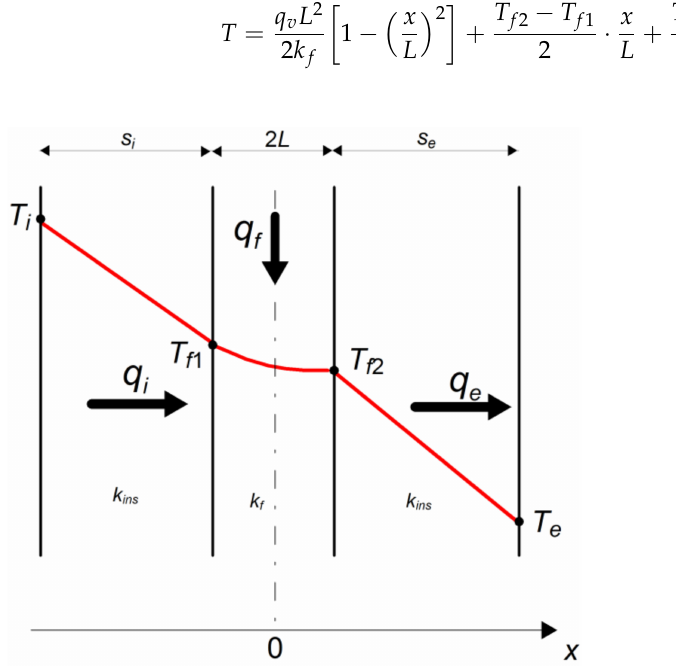
Figure A1. Three-layer wall with a heat source in the middle